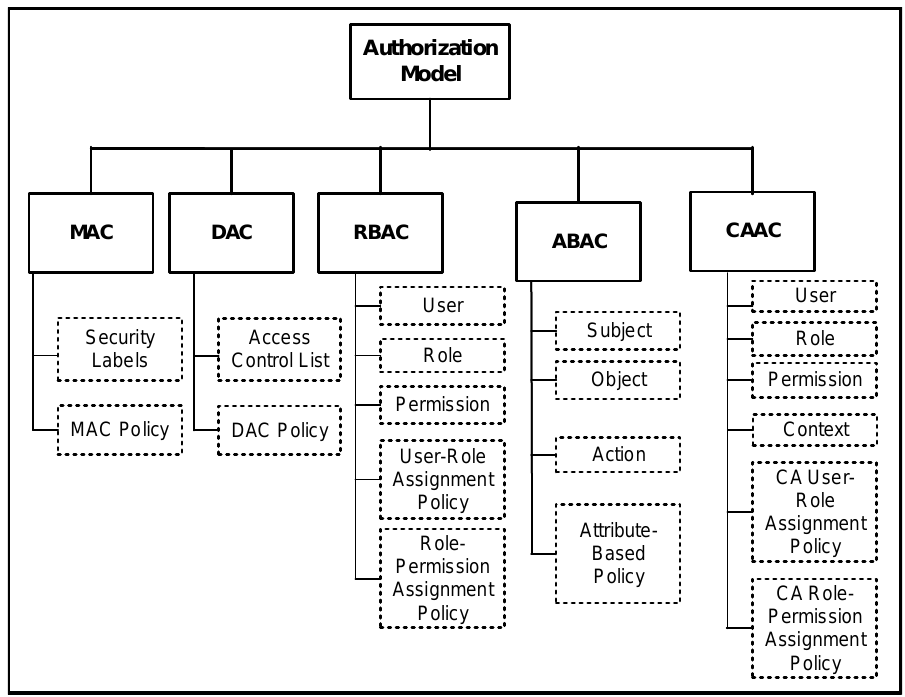
Figure 3. A taxonomy of authorization